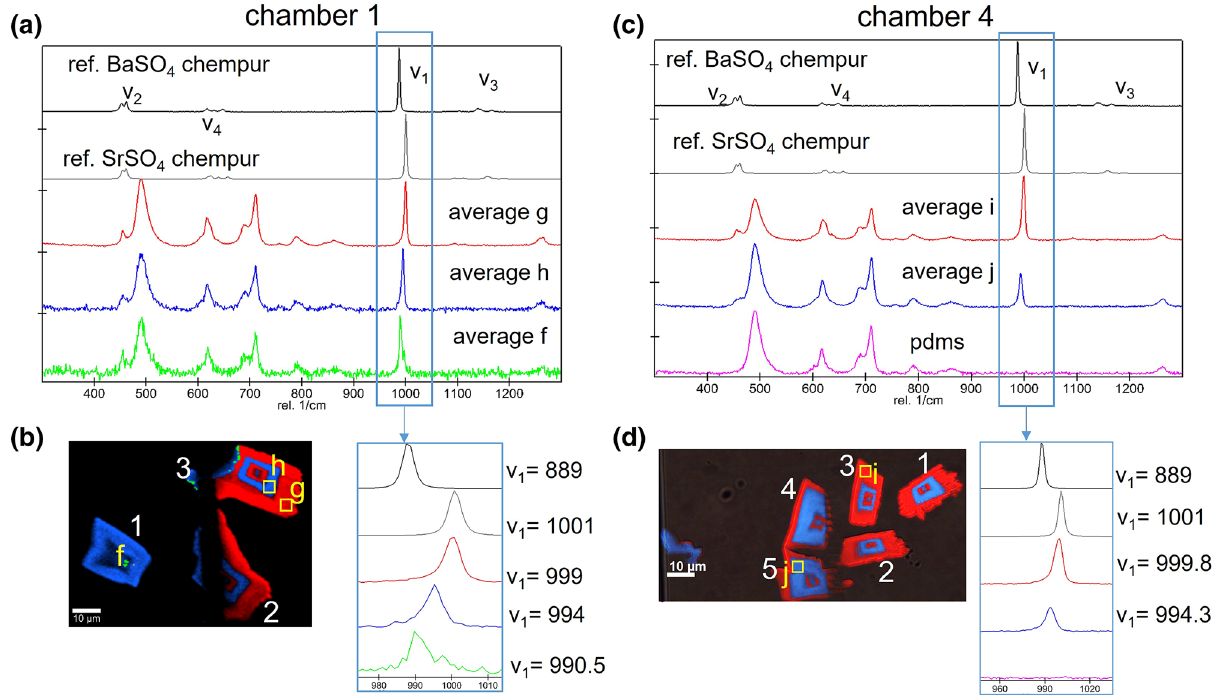
Figure 3. ( a ) Comparison of the average Raman spectra of the barium ( f , h ) and strontium ( g ) enriched layers of selected crystals in chamber 1 and those of commercial 99% pure BaSO 4 and SrSO 4 , ( b ) locations where the spectral averaging was done in chamber 1 with an enlargement of the ν 1 (SO 4 ) band, ( c ) comparison of the average Raman spectra of the barium ( j ) and strontium ( i ) enriched layers of selected crystals in chamber 4 and those of commercial 99% pure BaSO 4 and SrSO 4 and PDMS, ( d ) locations where the spectral averaging was done in chamber 4 along with corresponding Raman spectra of the ν 1 (SO 4 ) frequency